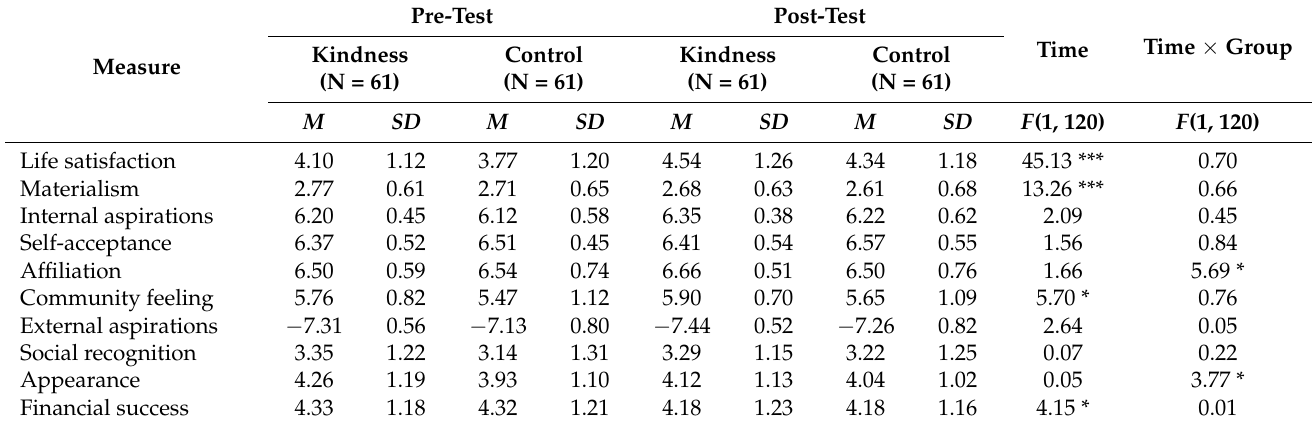
Table 2. Testing the kindness intervention on life satisfaction, materialism and